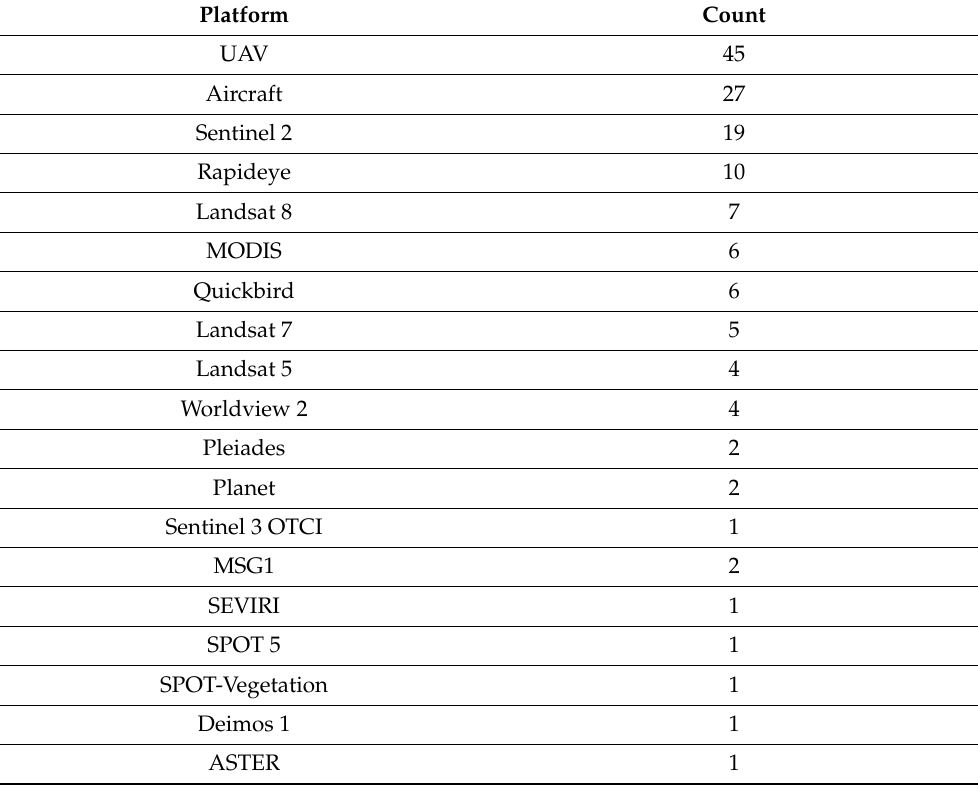
Table 1. Count of platforms used in